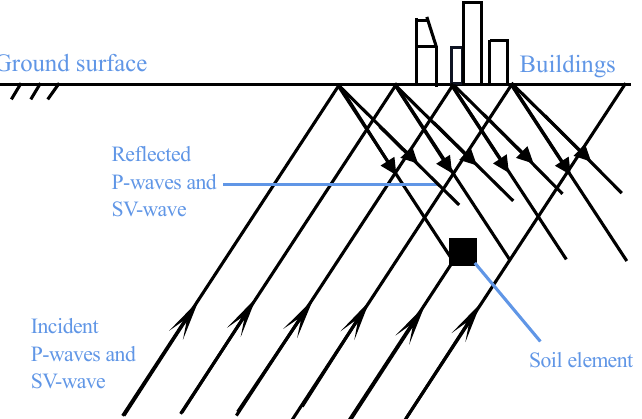
Figure 1. Diagrammatic sketch of obliquely incident seismic waves on building site.